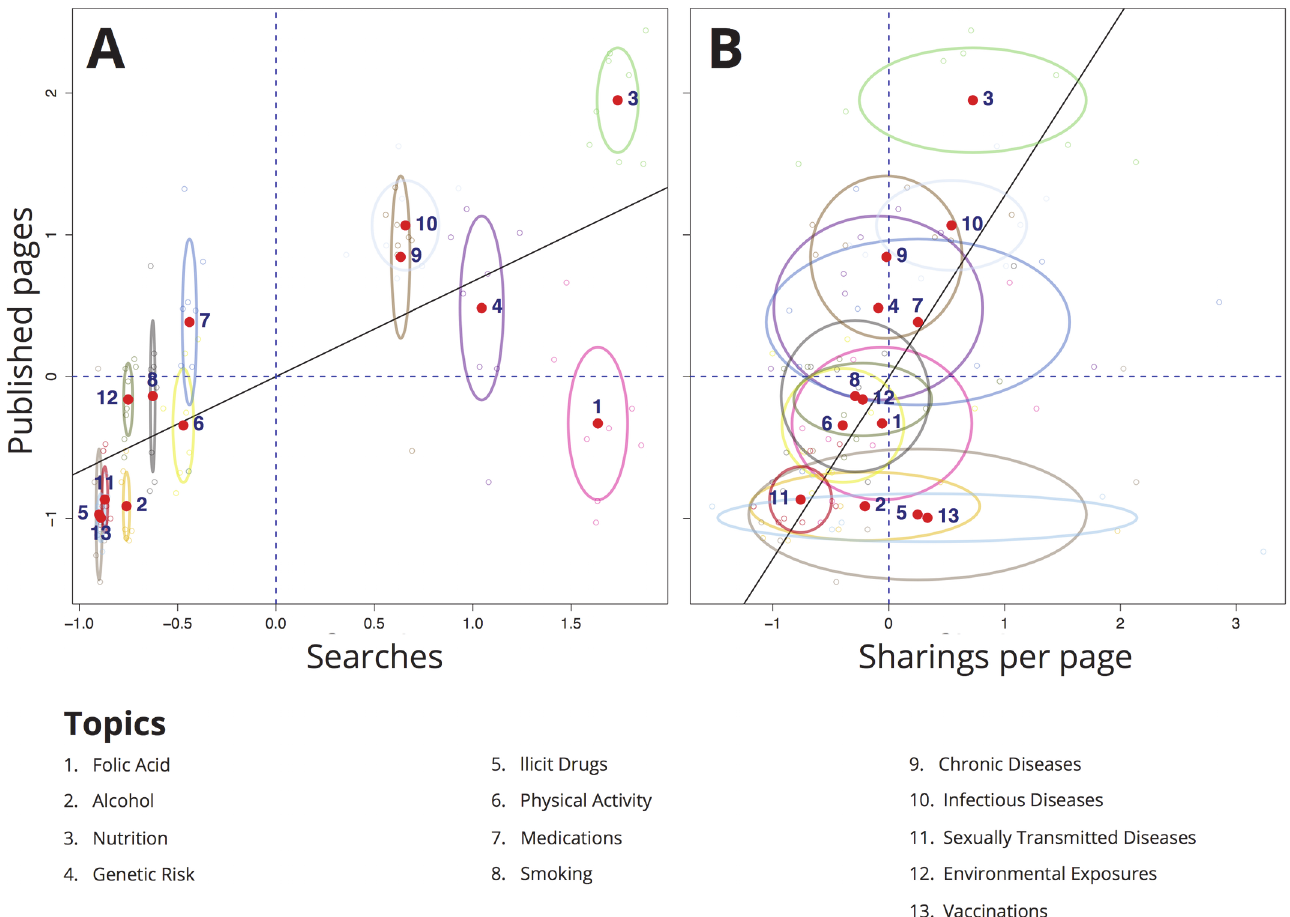
Fig 1. Correlation between the volumes of information pages with searches (A), and with the sharing/page ratio by topic (B).